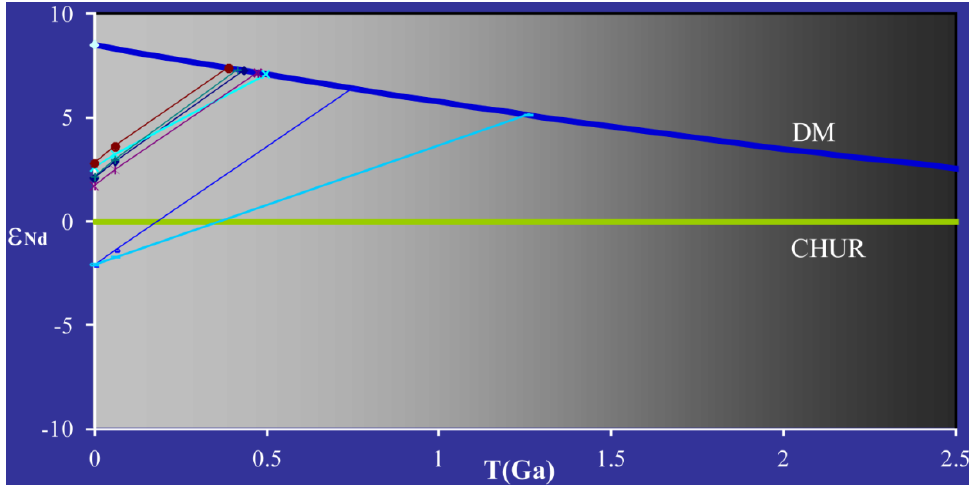
Figure 10. Diagram of Ɛ vs. T (Ga) for xenoliths from the CA, CU79, and CU80 Nd